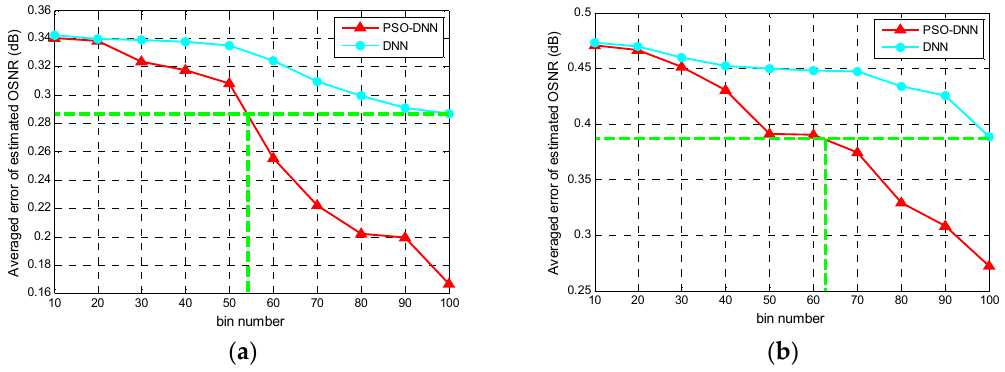
Figure 8. Averaged error of estimated OSNR for ( a ) PM-RZ-QPSK and ( b ) PM-NRZ-16QAM signals versus AHs bin number processed by the particle swarm optimization optimized deep neural network (PSO-DNN) and DNN.